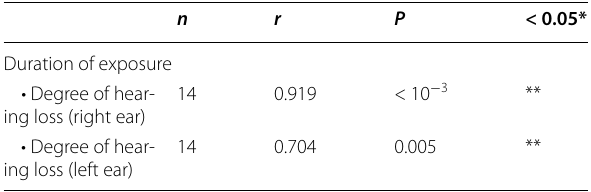
Table 4 Correlation between duration of exposure and degree of hearing